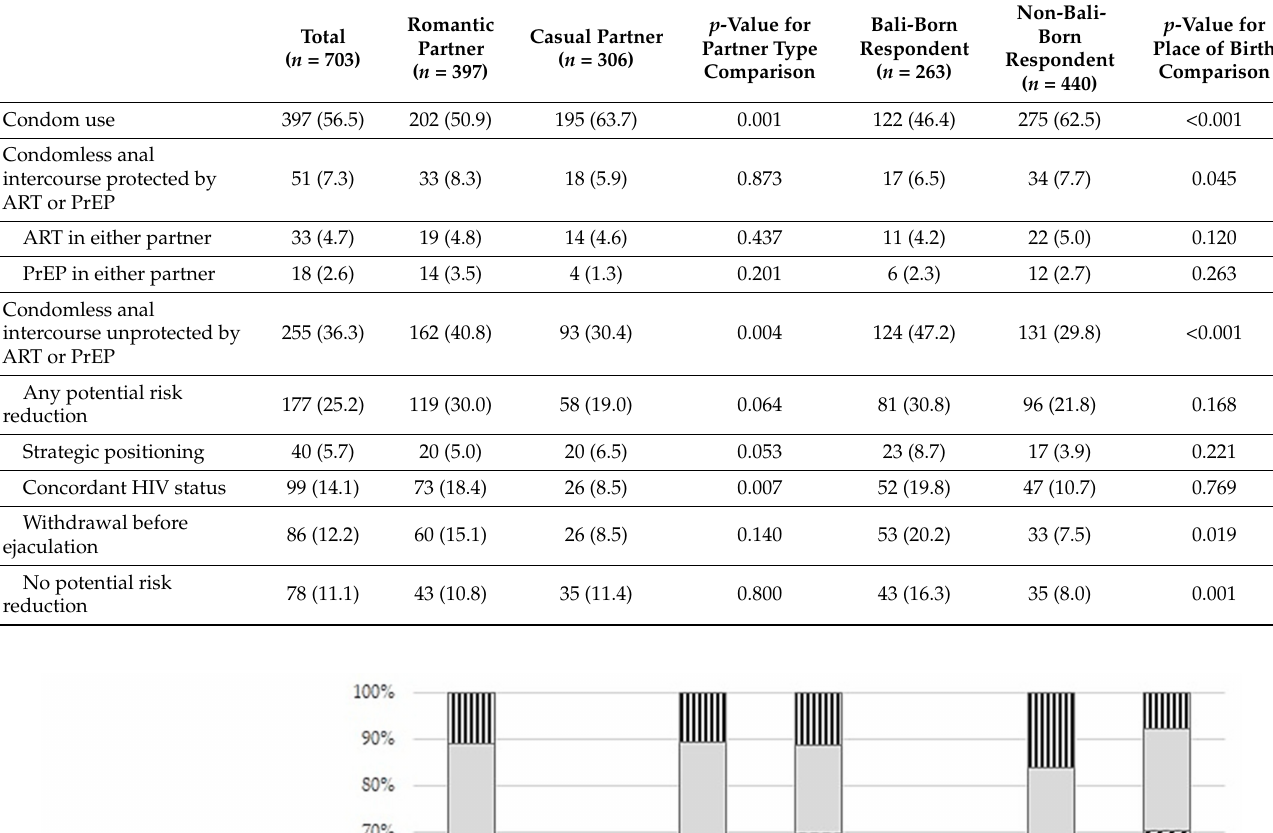
Table 2. Comparison of classifications of the most recent anal intercourse event: Total ( n = 703); by partner type (romantic partner, n = 397; casual partner, n = 306); and by respondent place of birth (Bali-born, n = 263; non-Bali-born, n = 440). ART, antiretroviral therapy; PrEP, pre-exposure prophylaxis.